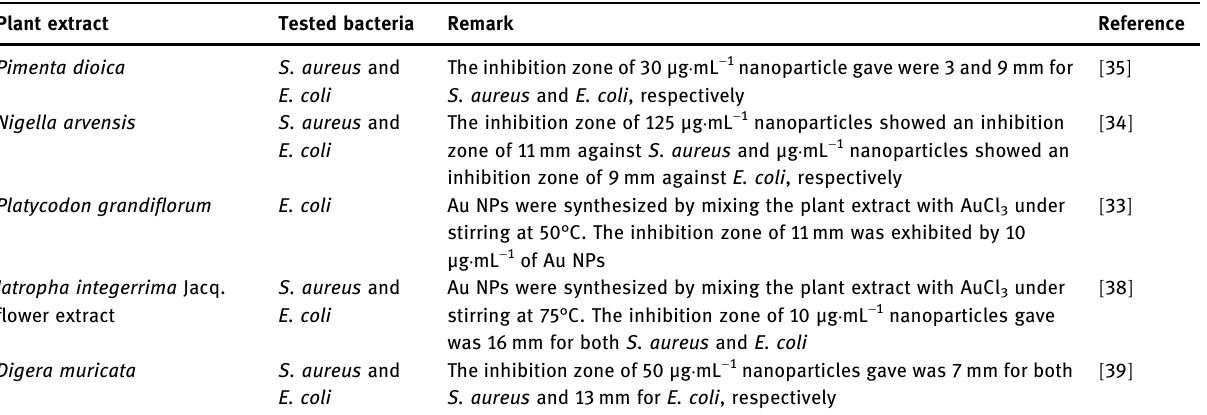
Table 2: Comparison of antibacterial activity of AuNPs using various plant extract Plant